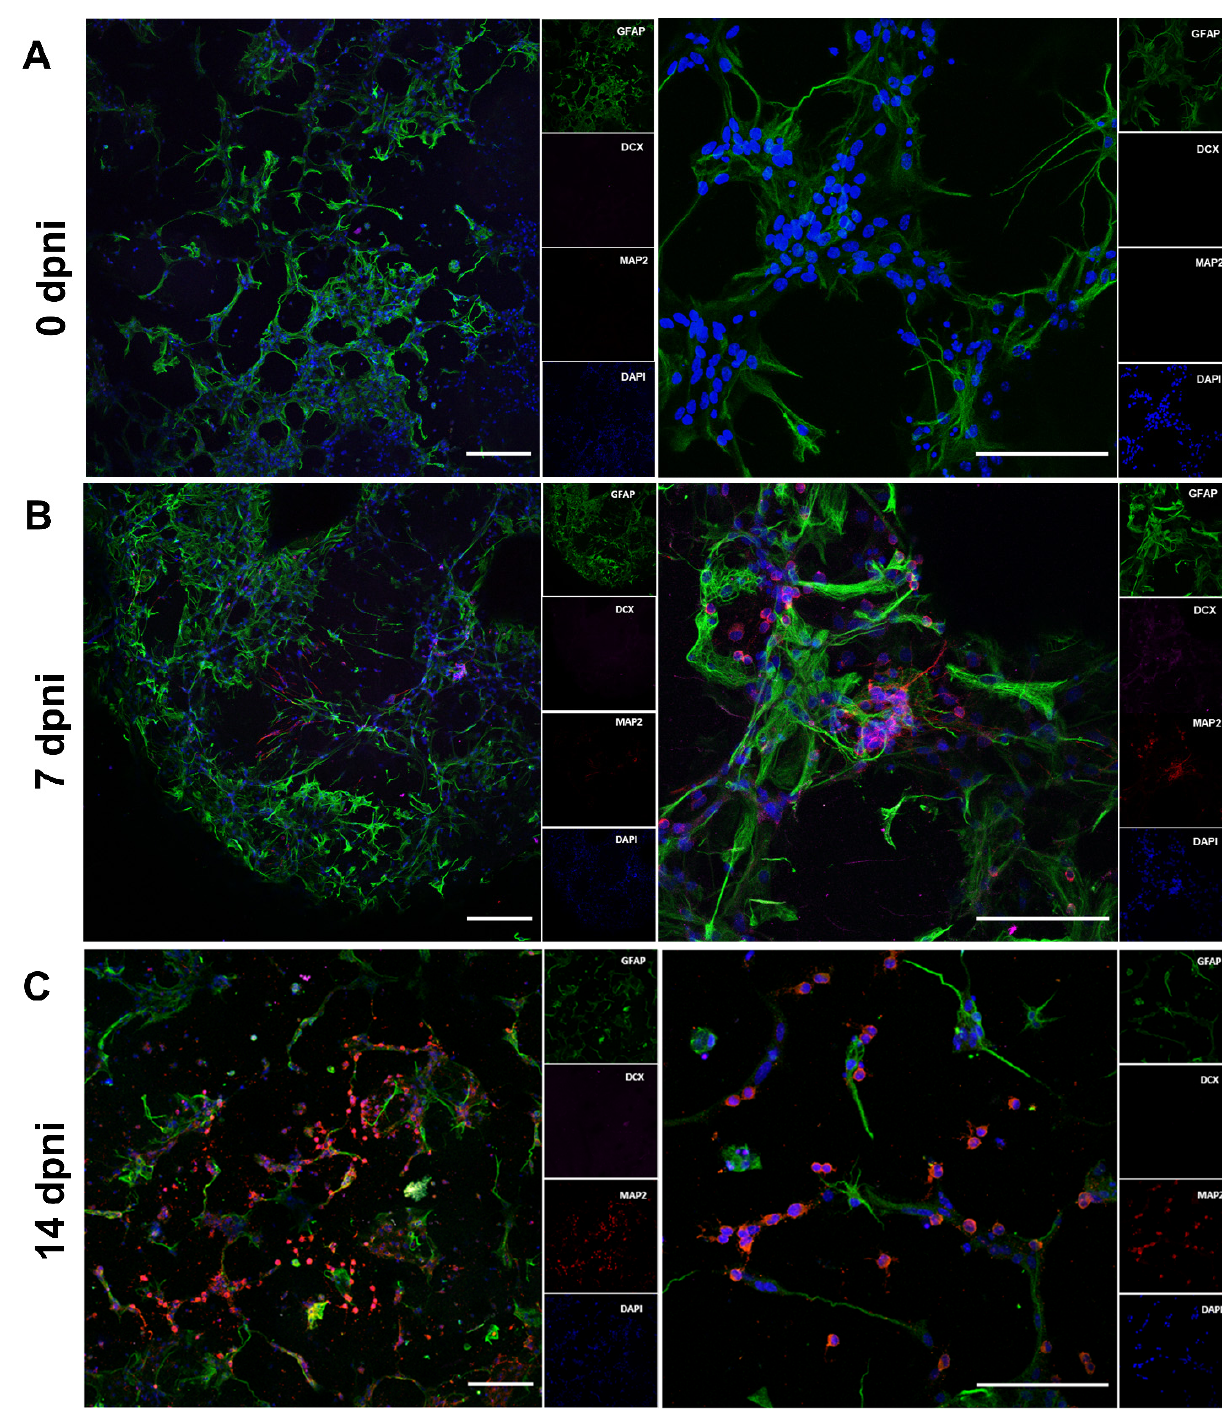
Figure 8. Immunofluorescence analysis of MAP2-positive cells from bioprinted non-reactive astrocytes in neural induction media. No MAP2-positive cells are observed in bioprinted astrocytes before de-differentiated astrocytes’ neuronal differentiation induction ( A ). MAP2-positive cells in bioprinted astrocytes 7 days after de-differentiated astrocytes’ neuronal differentiation induction ( B ). MAP2-positive cells in bioprinted astrocytes 14 days after de-differentiated astrocytes’ neuronal differentiation induction ( C ). Scale bar = 50 μ m. dpni = days post neuronal induction.